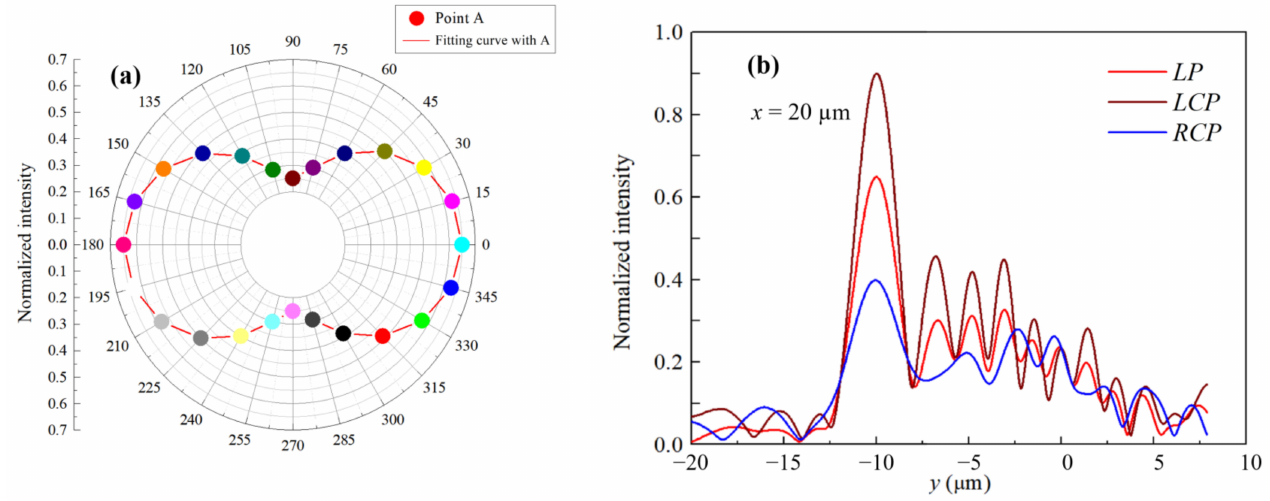
Figure 6. ( a ) Polar diagram for electric field intensities at points A with varied polarization angle γ with a = 0.16 µ m, b = 0.6 µ m. ( b ) Transverse electric field intensity distribution at x = 20 µ m for